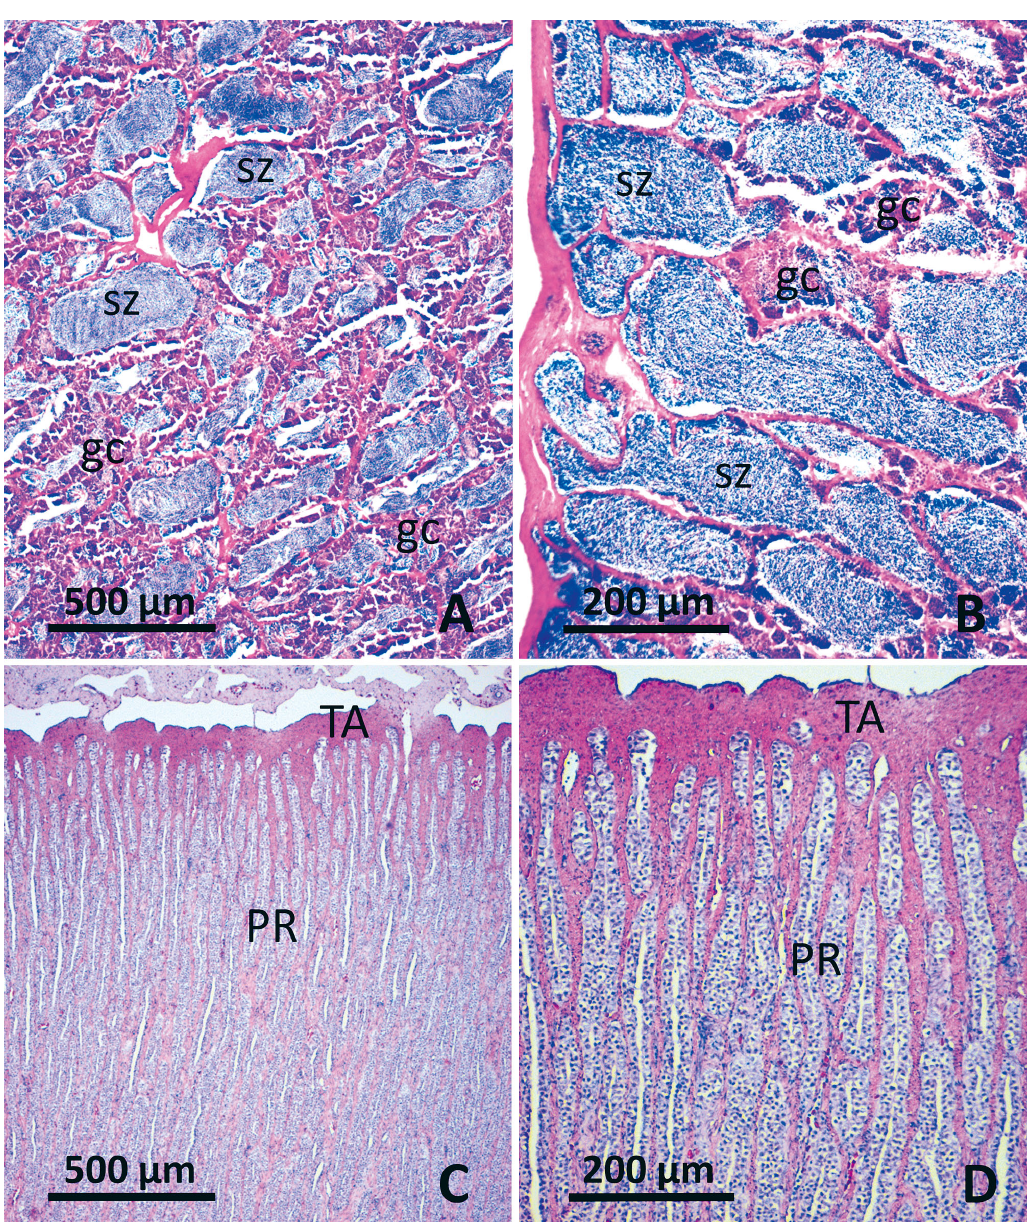
Fig. 3. Micrographs of Atlantic bluefin tuna Thunnus thynnus testes at the 2 maturation stages recognised in this study: (A) and (B) late spermatogenic stage (LS); (C) and (D) spent (S). gc: germinal cyst; PR: peripheral region of the testis showing lobules devoid of germinal cysts and spermatozoa; sz: spermatozoa; TA: tunica albuginea. Haematoxylin-eosin